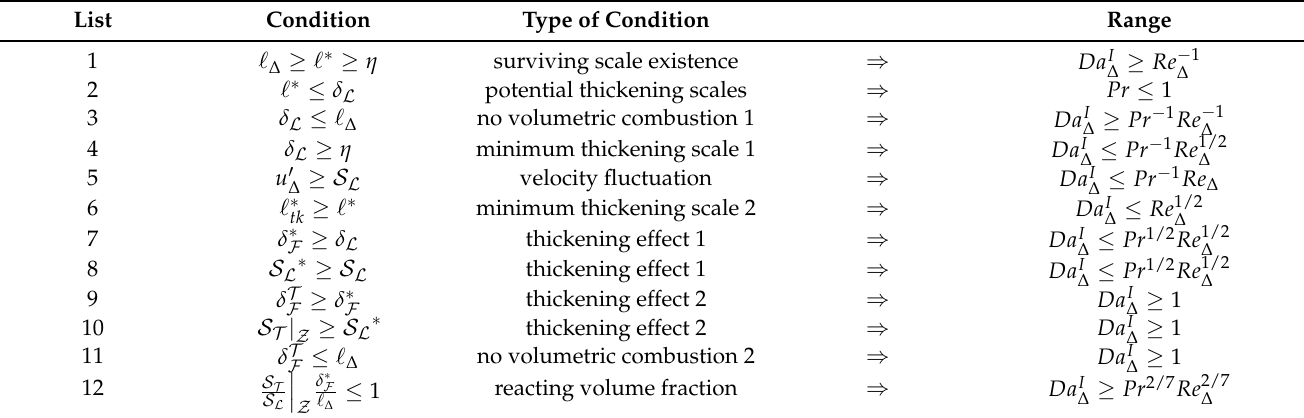
Table 1. Constraints to determine the validity range of the T urbulence – T hickened flame R egime